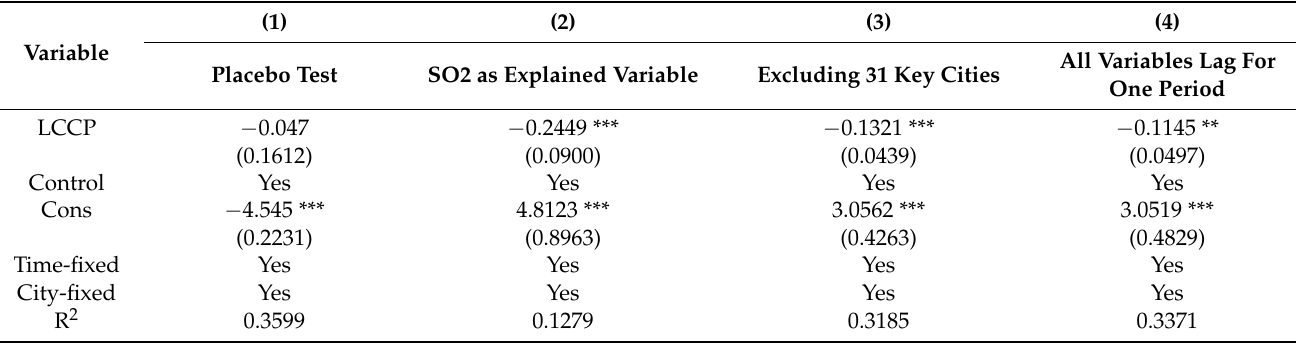
Table 6. Estimation results of the robustness